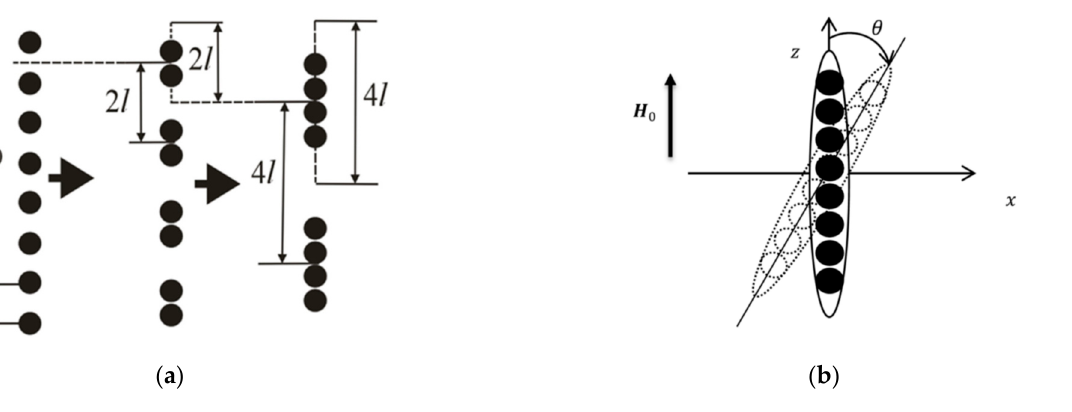
Figure 6. ( a ) Schematic representation of three first stages of the aggregation of agglomerates located on one axis of the lattice parallel to the external magnetic field strength H 0 . The number of agglomerates in the chain aggregate is determined by the balance between magnetic attraction and elastic constraints. Magnetic interactions the agglomerates located on different axes of the lattice are neglected. ( b ) Agglomerate chains are approximated by ellipsoids to describe their tilting under shear deformation [61].